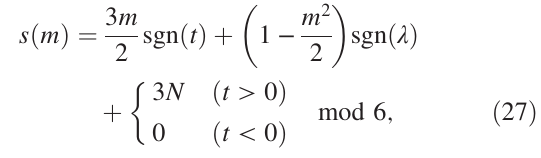
TABLE III. Spin of the gapped torus ground state of Haldane model in a few cases. Orbital angular momentum L